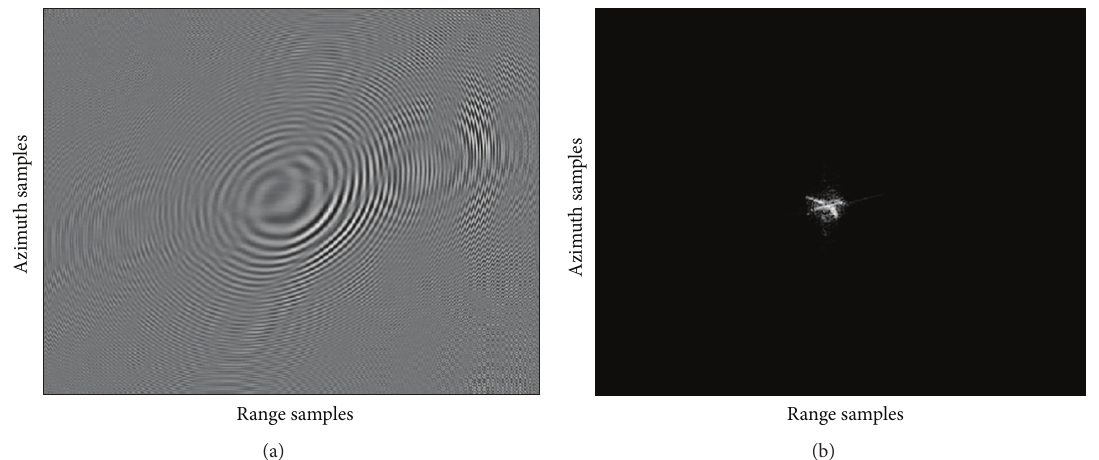
Figure 12: The simulated echo (a) and image (b) results of the plane model in the case of nonlinear motion.